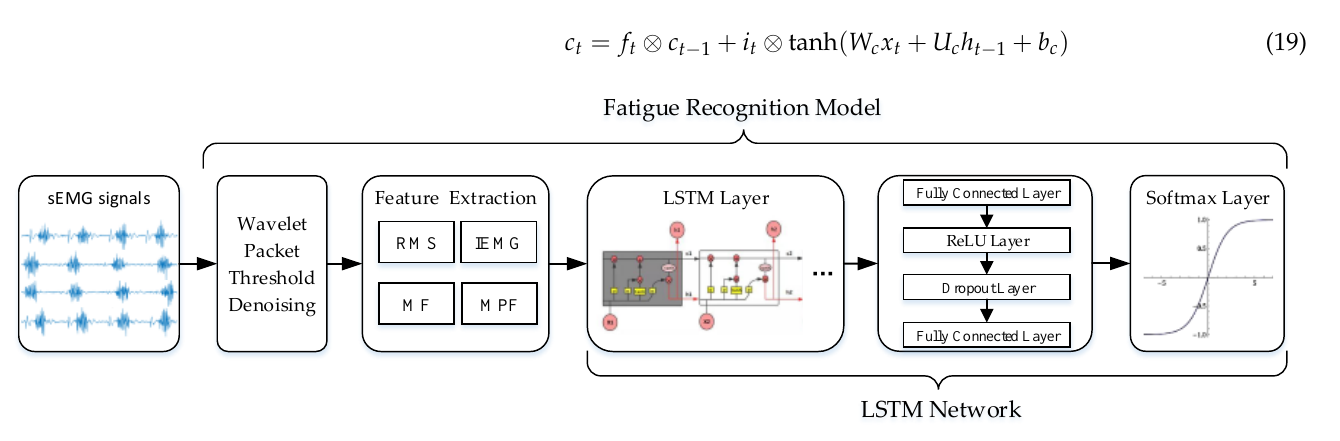
Figure 5. Representation of the proposed method.